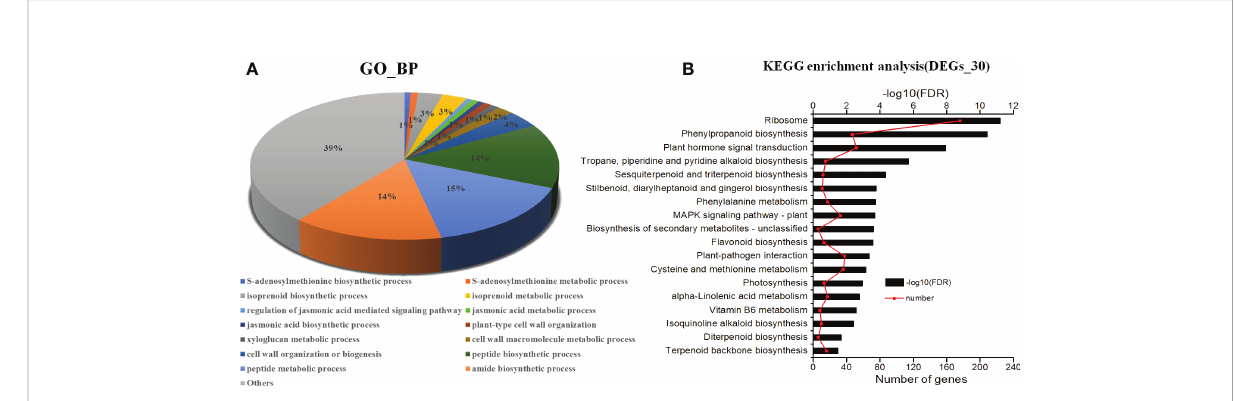
FIGURE 4 Analysis of KEGG (Kyoto Encyclopedia of Genes and Genomes) pathways and GO (Gene Ontology) enrichments. (A) KEGG pathways ( P < 0.001). (B) GO enrichments (biological processes, FDR<0.001). The data are for the functional classi fi cation of all